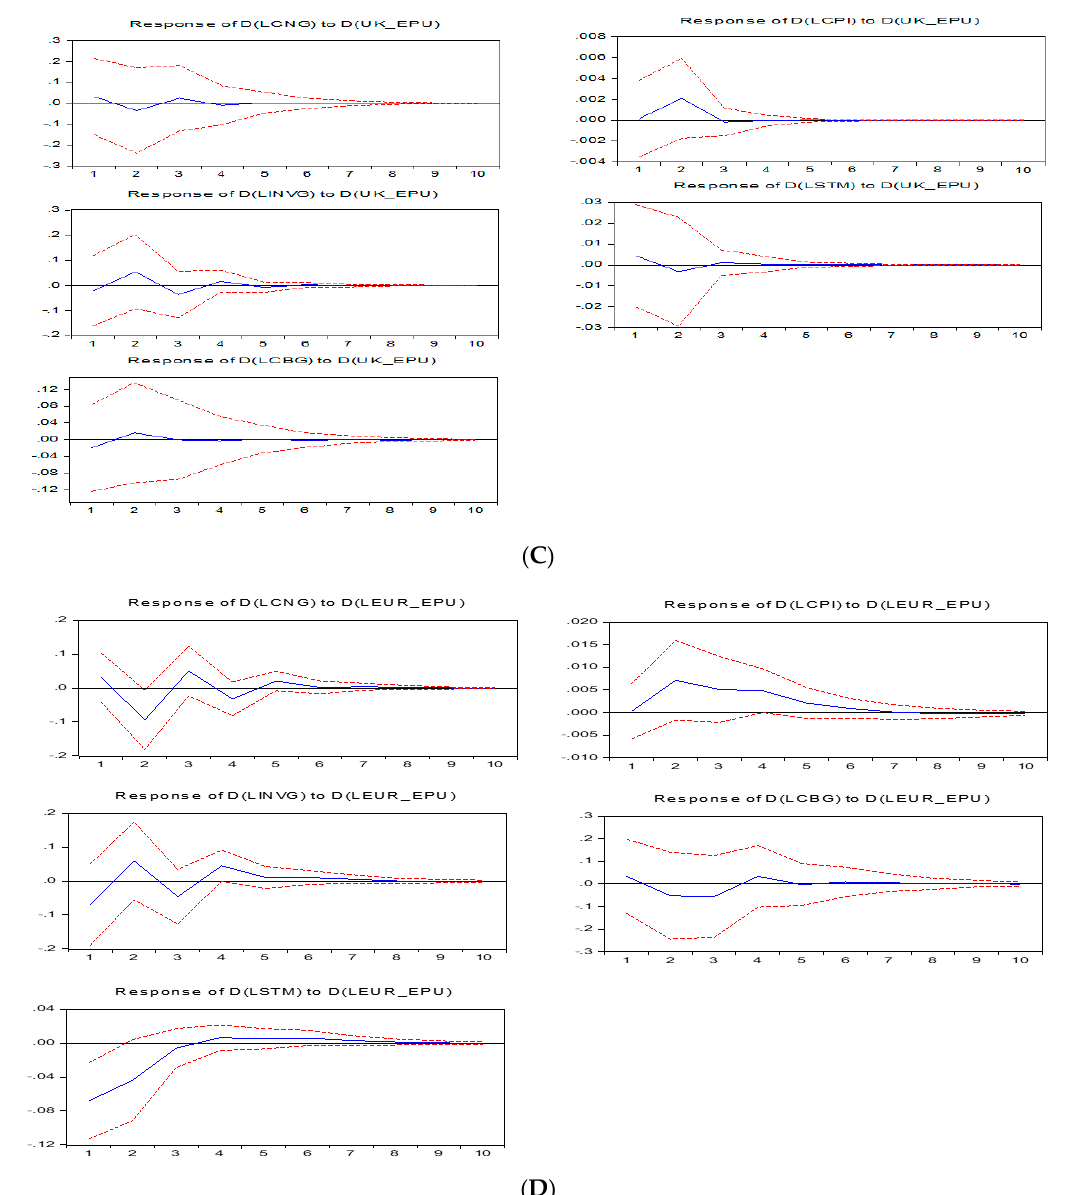
Figure 2. Shows the impulse response function of consumption, inflation, investment, credit growth and stock market to domestic EPU and foreign EPUs of USA, UK and Europe in context of Brazil. ( A ) Impact of Domestic EPU on India. Note: It shows the impulse response function of consumption, inflation, investment, credit growth and stock market to a Cholesky one standard deviation Domestic EPU context of India. Whereas, the two outer lines are Monte Carlo constructed 95% confidence interval. ( B ) Impact of US EPU on India. Note: It shows the impulse response function of consumption, inflation, investment, credit growth and stock market to a Cholesky one standard deviation Foreign EPU i.e., USA in context of India. Whereas, the two outer lines are Monte Carlo constructed 95% confidence interval. ( C ) Impact of UK EPU on India. Note: It shows the impulse response function of consumption, inflation, investment, credit growth and stock market to a Cholesky one standard deviation foreign EPU i.e., UK in context of India. Whereas, the two outer lines are Monte Carlo constructed 95% confidence interval. ( D ) Impact of Europe EPU on India. Note: It shows the impulse response function of consumption, inflation, investment, credit growth and stock market to a Cholesky one standard deviation foreign EPU i.e., Europe in context of India. Whereas, the two outer lines are Monte Carlo constructed 95% confidence interval.